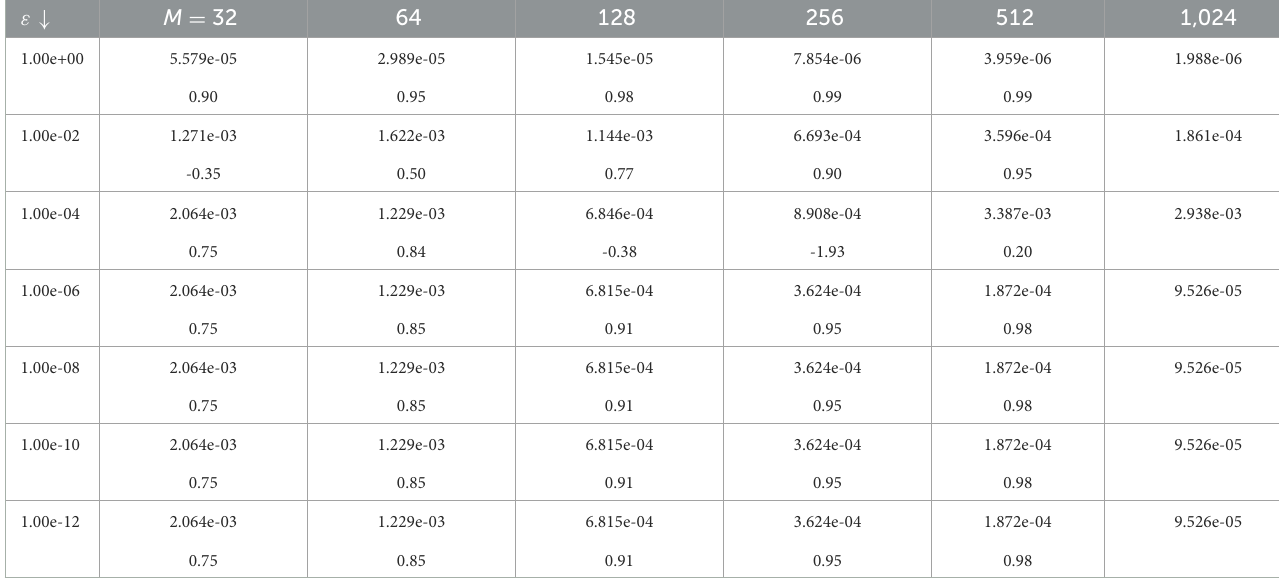
TABLE 2 Maximum absolute errors for Example 4.1 for N = 10 at the number of intervals M .